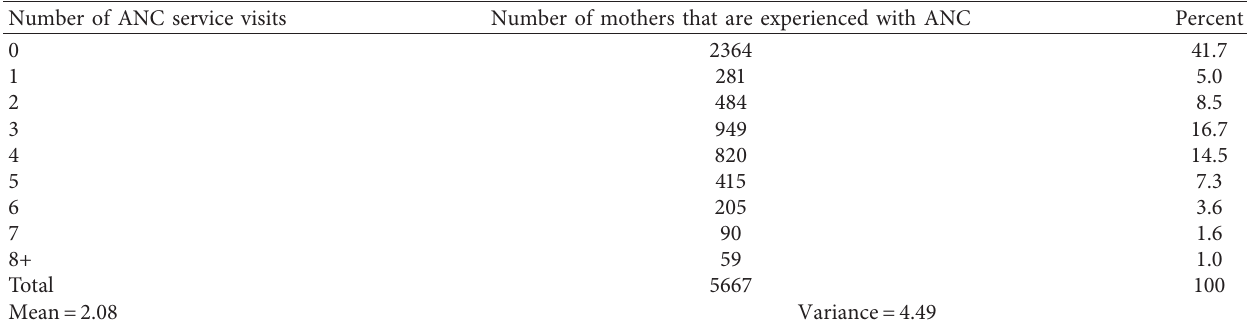
Table 1: Frequency distribution of the number of antenatal care visits per woman. Number of ANC service visits Number of mothers that are experienced with